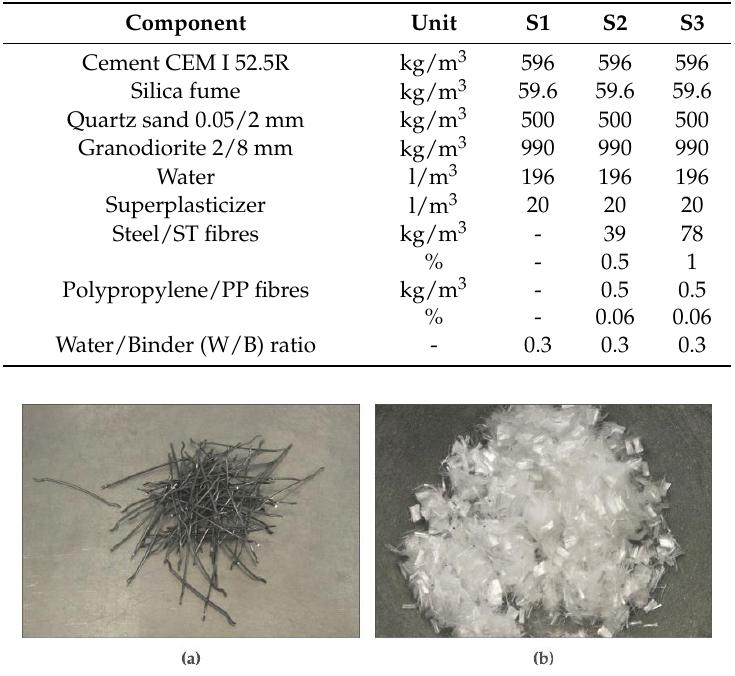
Figure 1. ( a ) Hooked-end steel fibres; ( b ) Polypropylene fibres.